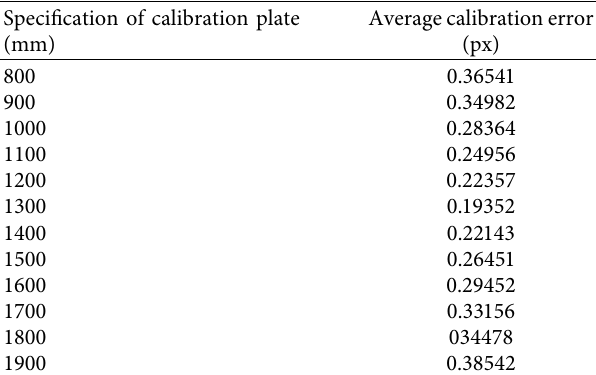
Table 3: Average calibration error of Experiment b.